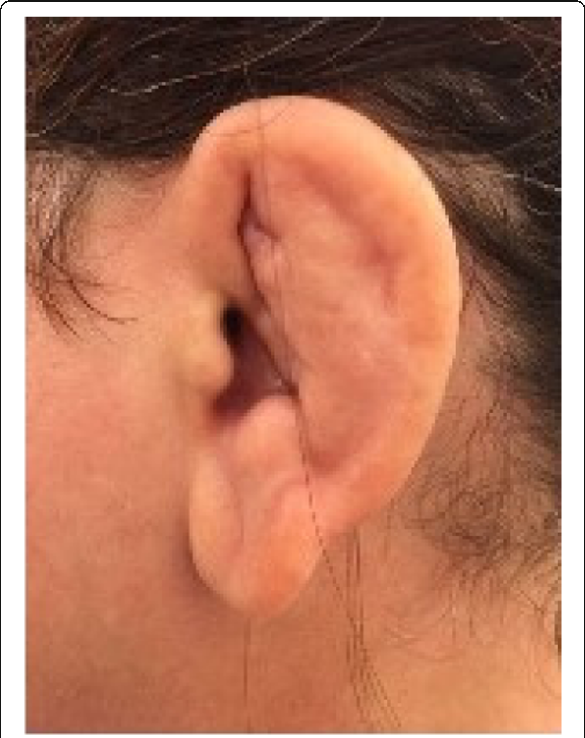
Fig. 1 (abstract P443). Infiltrative edema in auricular pavilions bilaterally